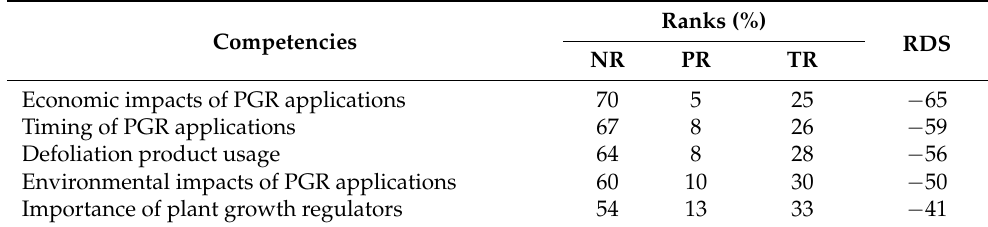
Table 5. Ranked Discrepancy Scores for individual competencies in other chemical applications, which include plant growth regulators (PGR) and defoliants. Competencies